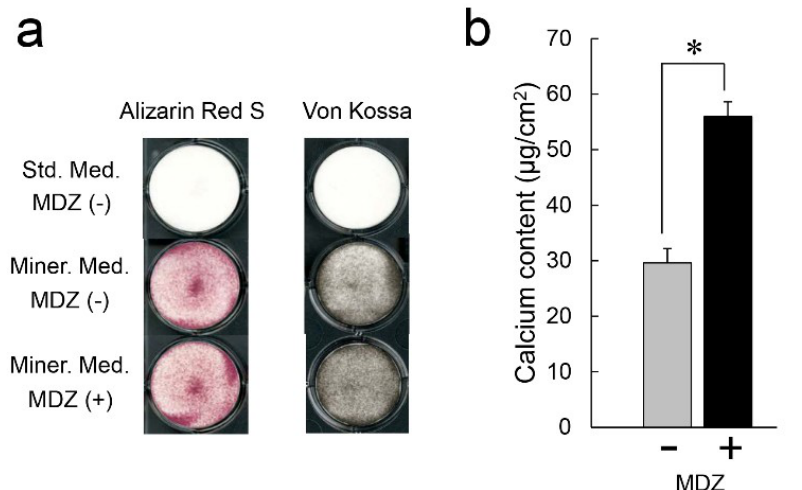
Figure 3. Effect of MDZ on nodule formation in the PPU-7 cell line. Nodule cultures were stained with ( a ) Alizarin Red S (left) and von Kossa (right) staining on day seven. In contrast to PPU-7 cells not subjected to mineralization induction, PPU-7 cells cultured in mineralization-inducing culture media clearly exhibited nodule formation regardless of the addition of MDZ. ( b ) Calcium contents in PPU-7 cells were determined on day five after the mineralization induction. Values are the means ± standard error of six culture wells. The asterisk (*) on the bar graph indicates a significant difference ( p < 0.05, Mann–Whitney U-test) between the cells incubated with and without MDZ. Std. Med.: Standard culture medium, Miner. Med.: Mineralization-inducing culture medium.